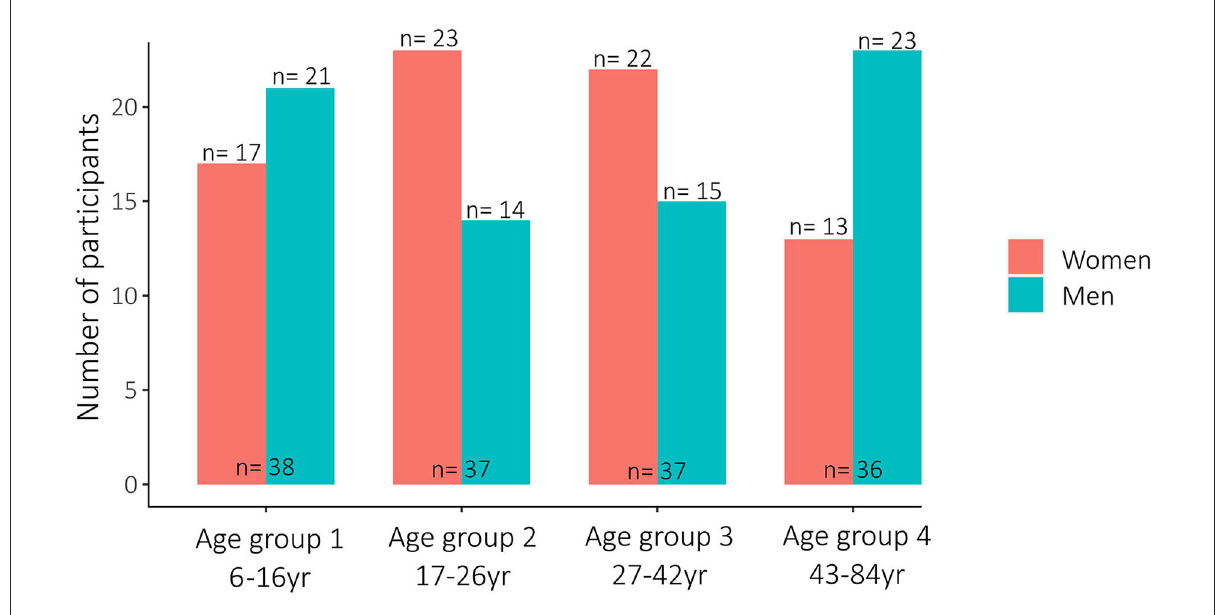
FIGURE2 Overview of all study participants per age groups and sex.